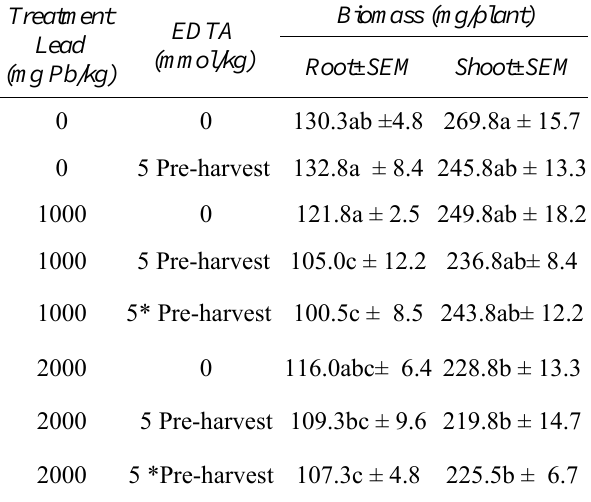
Table 1: Effects of various concentrations of Pb and chelates on root and shoot dry biomass of tall fescue. For each organ, means with a similar letter do not differ significantly using Fisher’s Protected LSD test ( p ≤ 0.05).